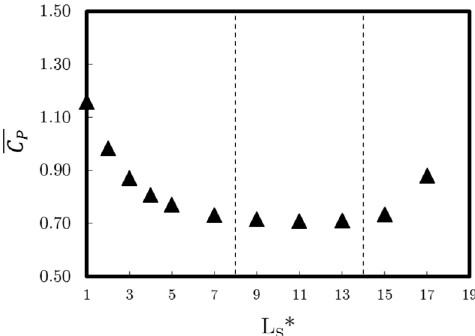
Fig. 10. Variation of the average power coef fi cient (BEM-RANS prediction) for a single-row array of HPSs with n = 3 and ’ = 0.08 as a function of the lateral spacing L